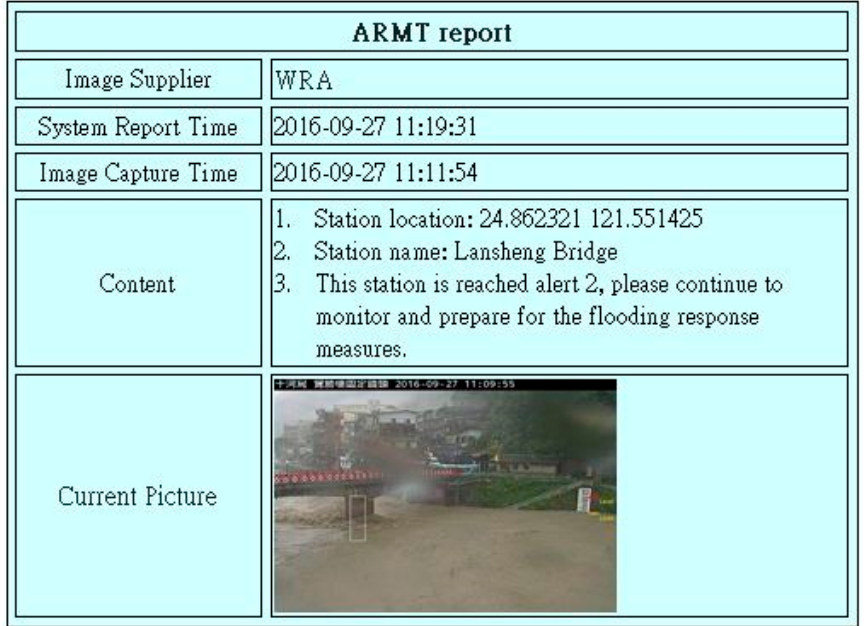
Figure 8. The alert message report of ARMT by e-mail.